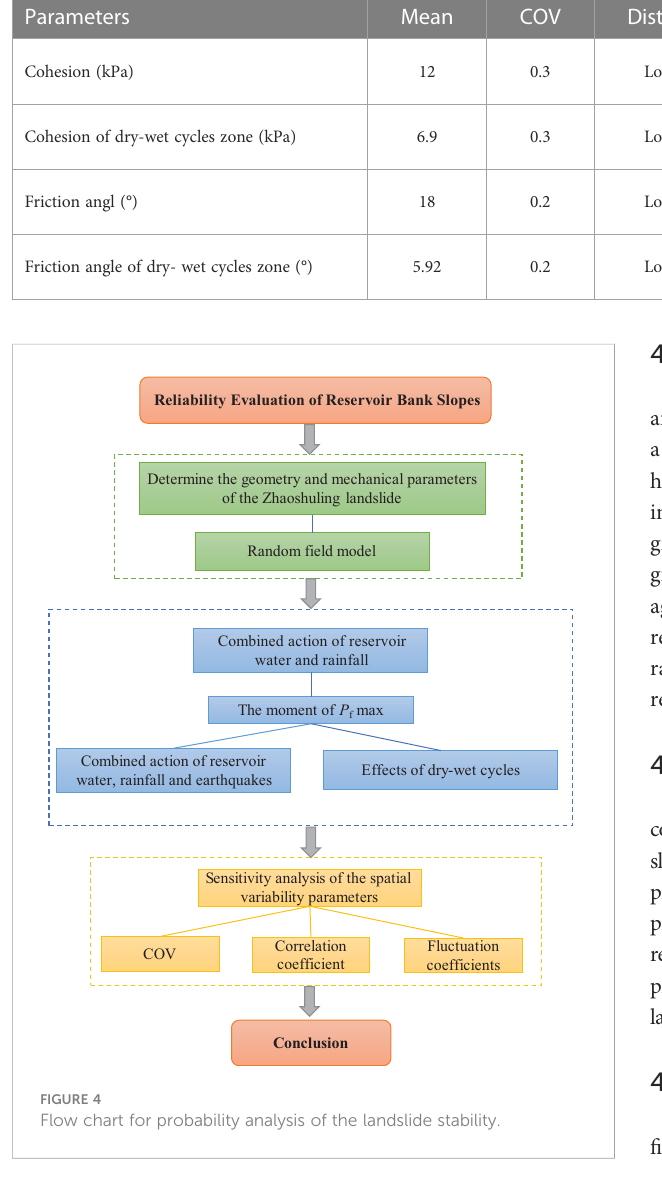
FIGURE 4 Flow chart for probability analysis of the landslide stability.